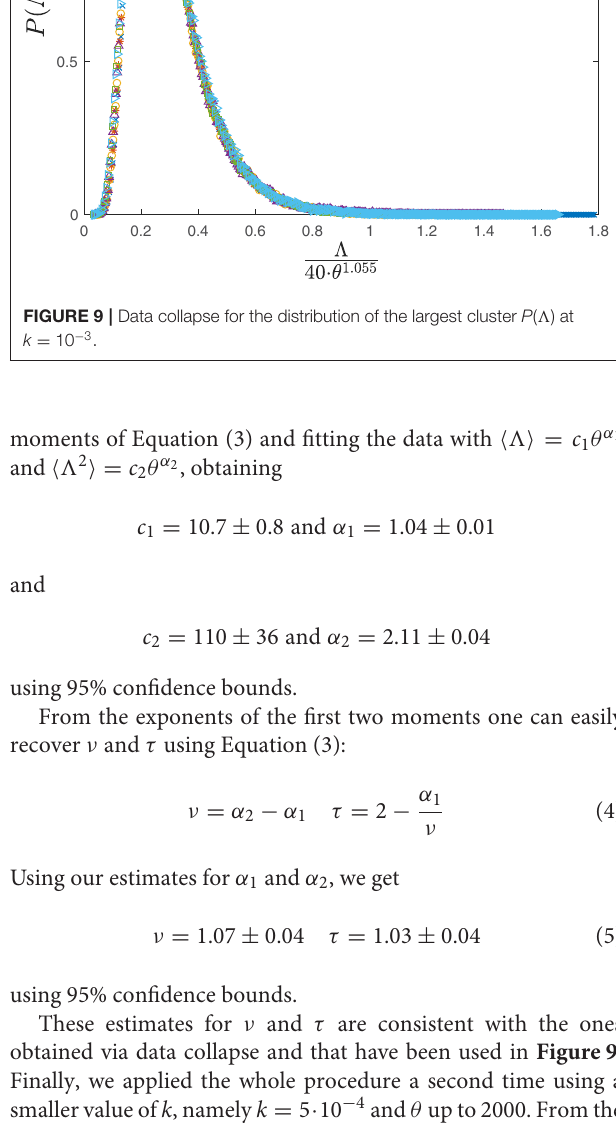
moments of Equation (3) and fitting the data with h 3 i = c 1 θ α